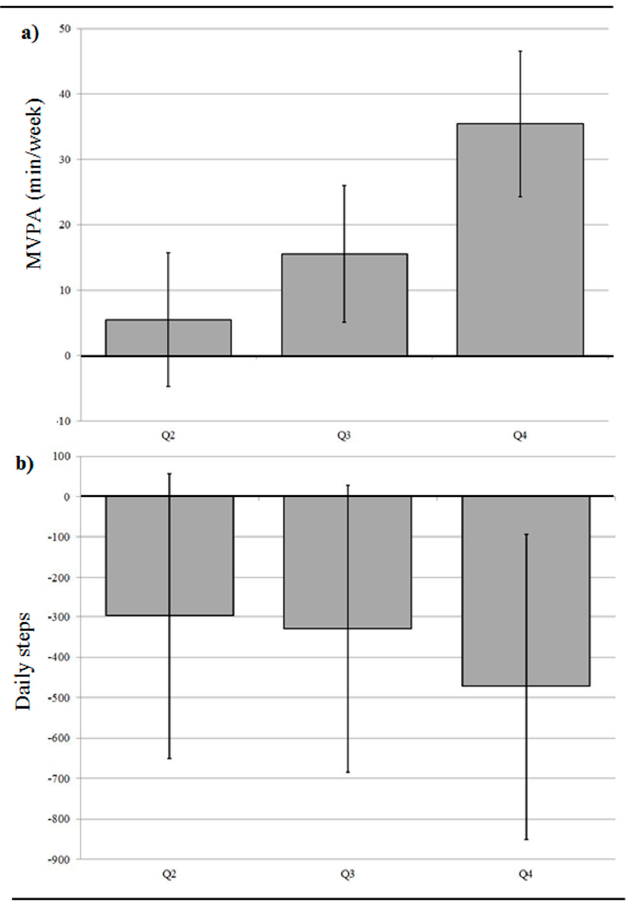
Figure 2. Differences in time spent in moderate-to-vigorous intensity physical activity (MVPA) and total accumulated daily steps (95% confidence intervals) in higher neighborhood active-living-friendliness index quartiles (Quartile 2, 3, and 4) compared to the lowest